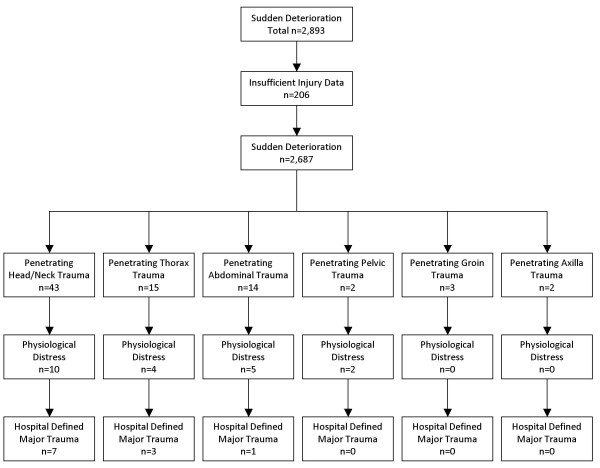
Sudden Deterioration, Penetrating Trauma, Physiologically Distress and Hospital Defined Major Trauma.